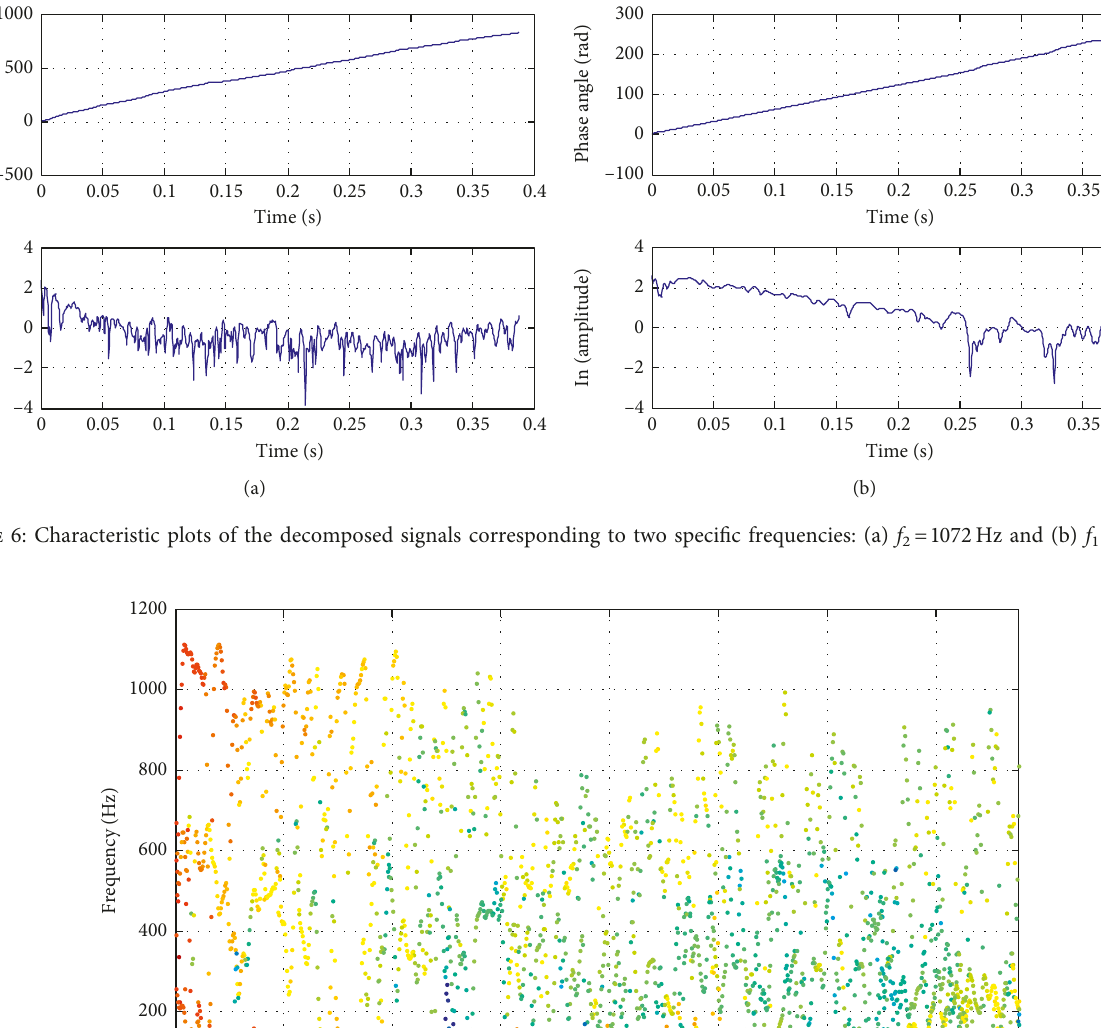
Figure 7: Hilbert spectrum of intrinsic mode